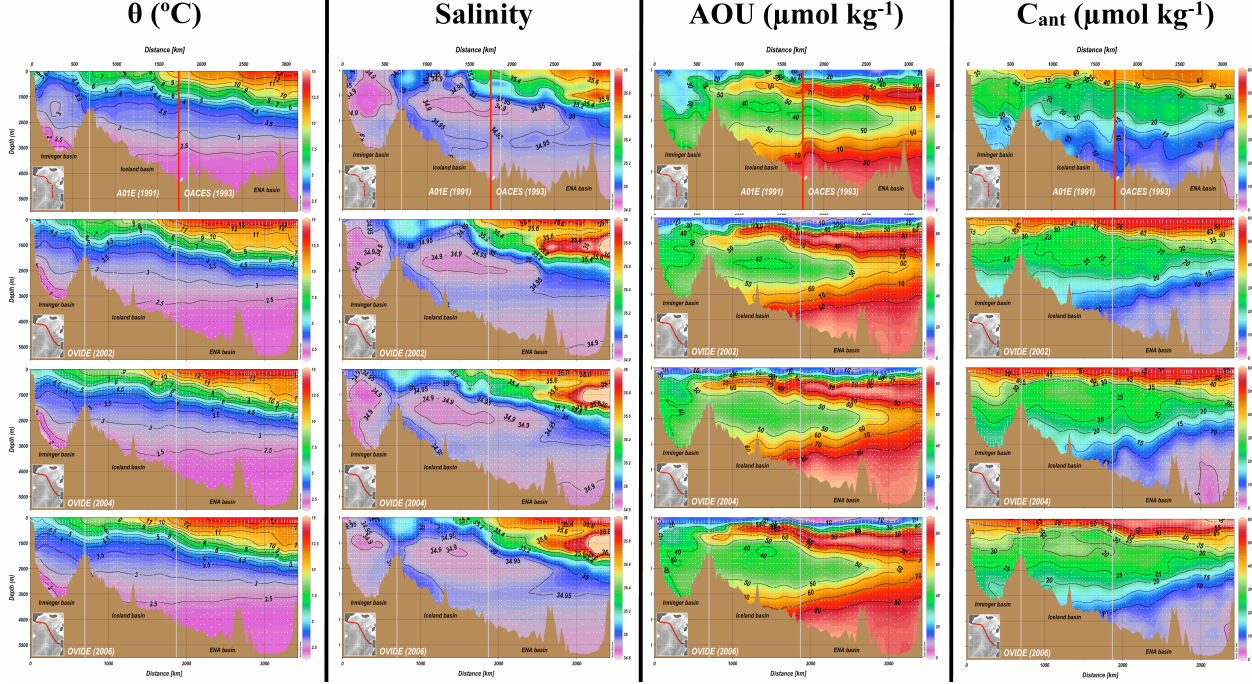
Fig. 2. Contour plots of θ , Salinity ( S) , AOU and C ant concentration spanning from 1991 to 2006. The x-axis gives the track distances (km) from the southernmost tip of Greenland towards the Iberian Basin. The small white dots in each sub-plot indicate bottle depths and the grey vertical lines demarcate basin separations. The top row section is a composite from the A01E (1991) and OACES (1993) cruises (separated by thick red vertical line), in order to get the closest match possible with the OVIDE section. Notice that the selected A01E leg perfectly overlaps with the OVIDE tracks. This was done in order to extend directly comparable measurements and C ant estimates of the OVIDE project further back in time by nearly a decade and get a better track of the storage trends. Compared with the nine-year gap between this composite section and the first OVIDE cruise in 2002, the temporal difference between the A01E and OACES cruises is negligible and affordable. On the top composite sections, the continuum fields at the insertion point of the upper, intermediate and deep waters corroborate this assumption and validate the combination of